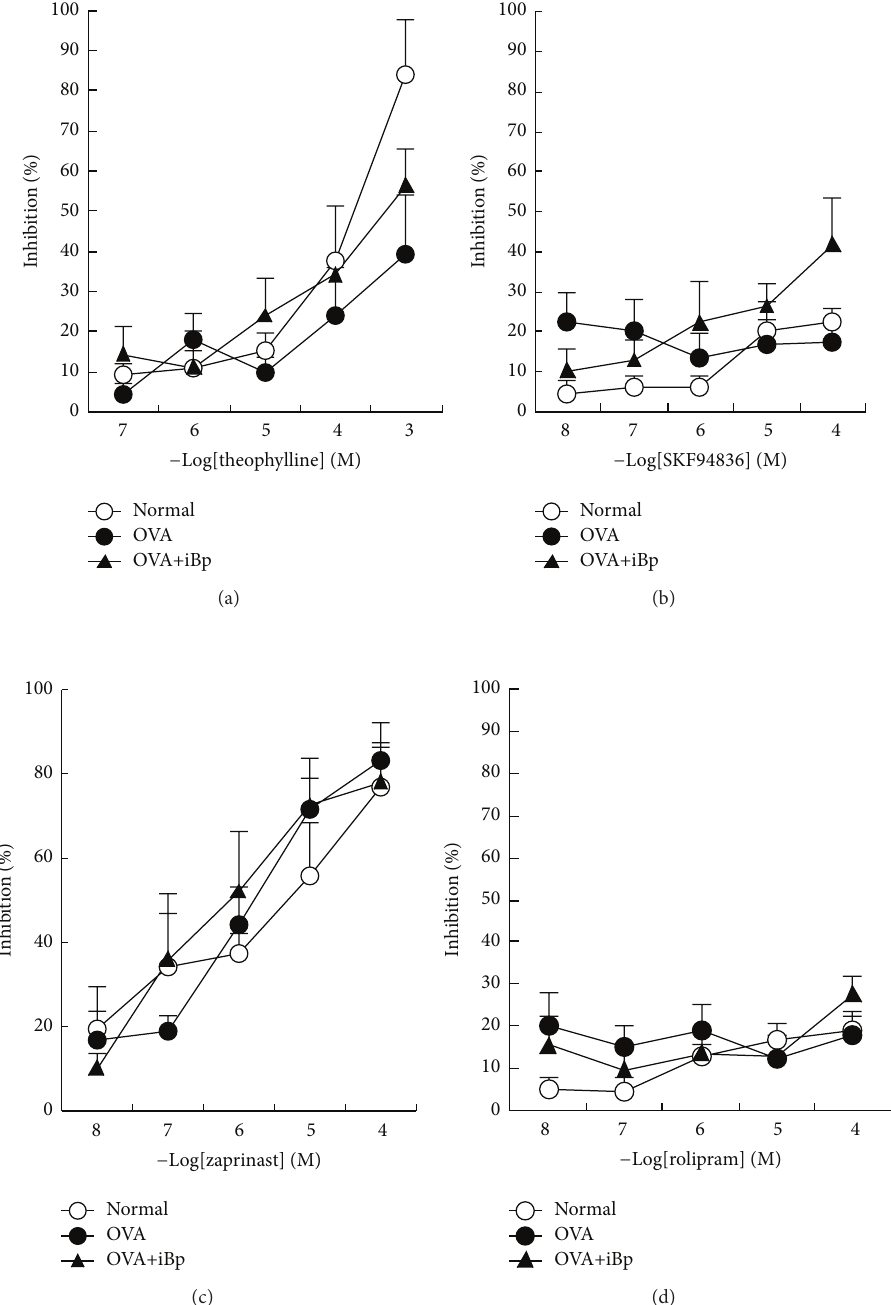
Figure 4: Inhibitory effects (%) of theophylline (a), SKF94836 (b), zaprinast (c), and rolipram (d) on the cGMP-PDE activity in the lung homogenates harvested from OVA+iBp and OVA rats (mean ±